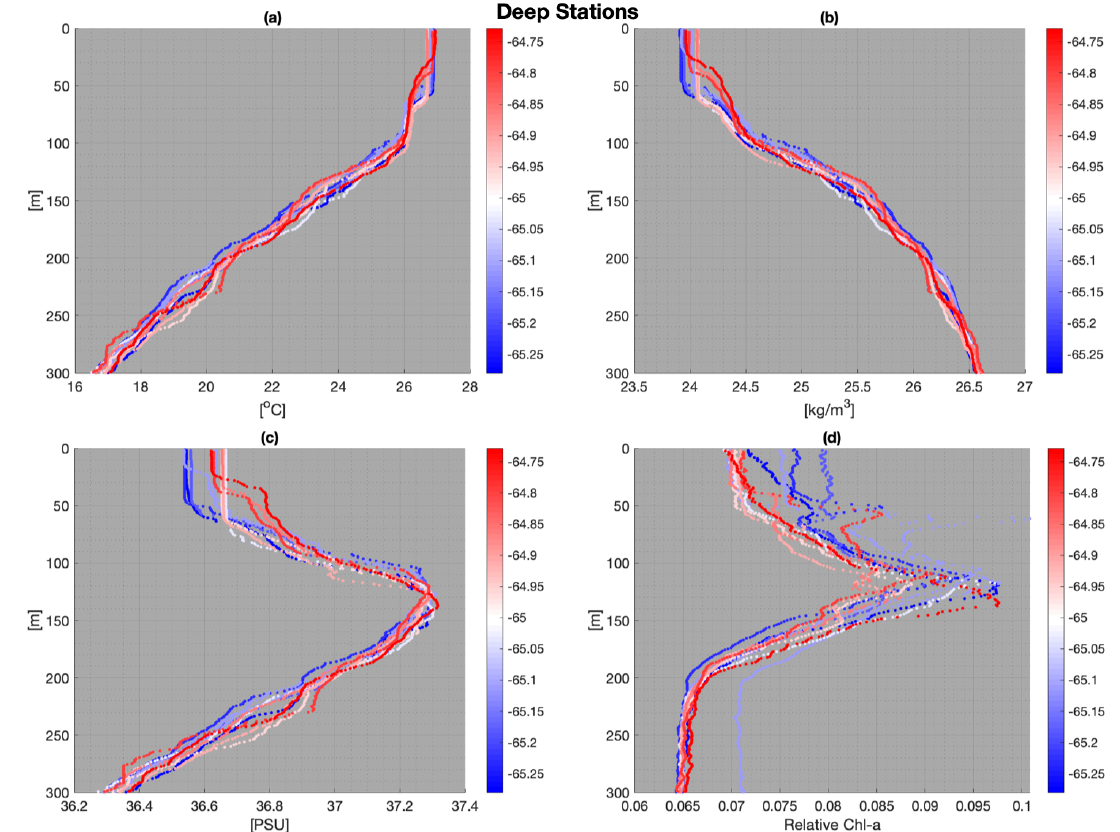
Figure 7. ( a ) Temperature, ( b ) density, ( c ) salinity, and ( d ) relative Chl-a profiles for deep stations. Color represents their location by